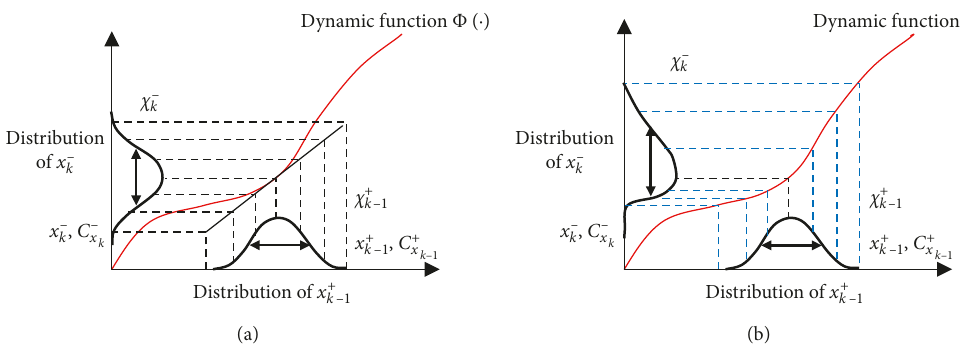
Figure 9: Explanation of the dynamic mapping to determine the distribution of the x at the sampling time k via the nonlinear function calculated by the distribution of x at the sampling time k − 1 for the (a) EKF and (b)